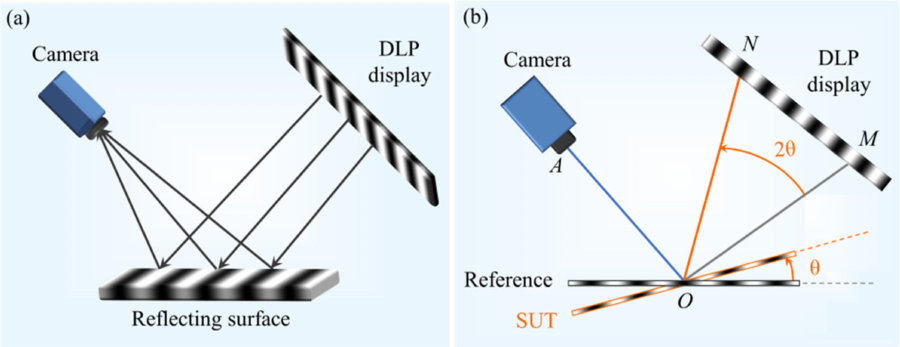
Figure 1. ( a ) Schematic diagram of PD system; ( b ) basic principle of PD for defect